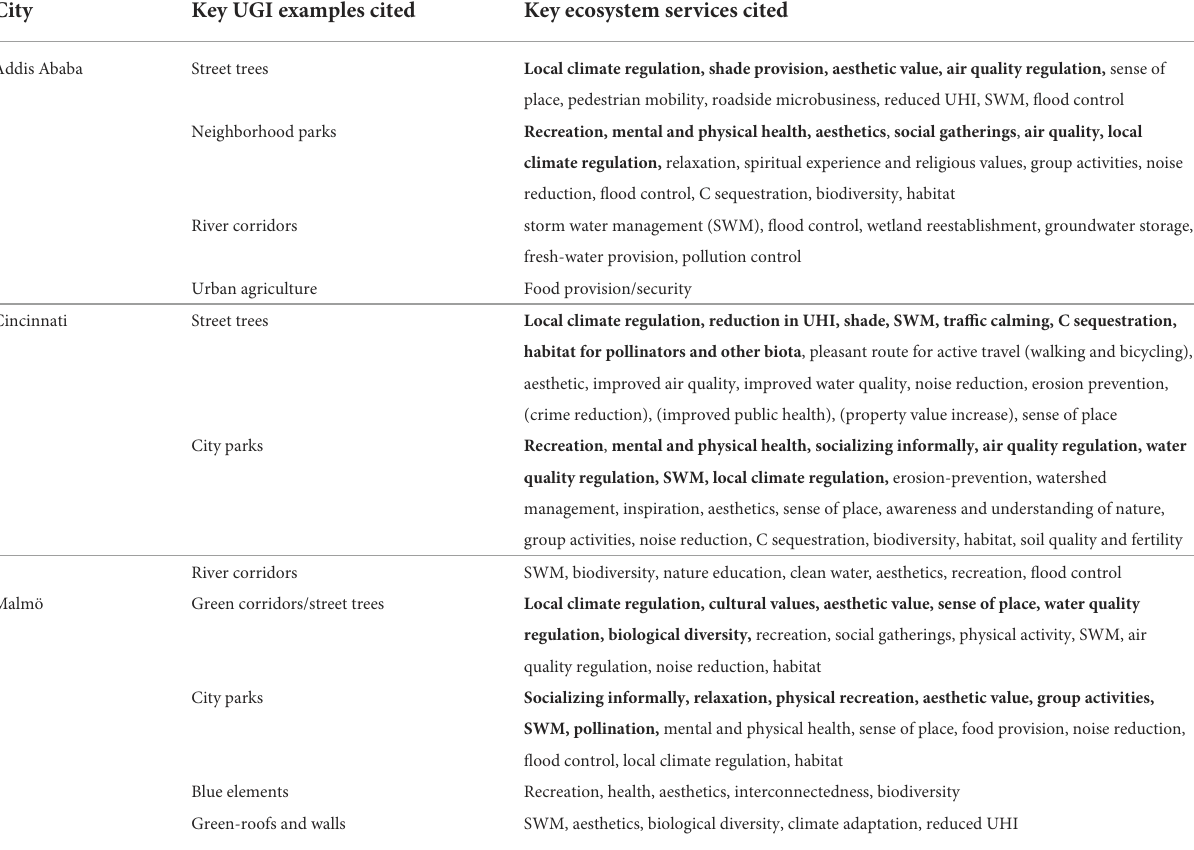
TABLE 3 UGI/NbS elements and the associated ES that were most commonly emphasized during the expert stakeholder interviews.